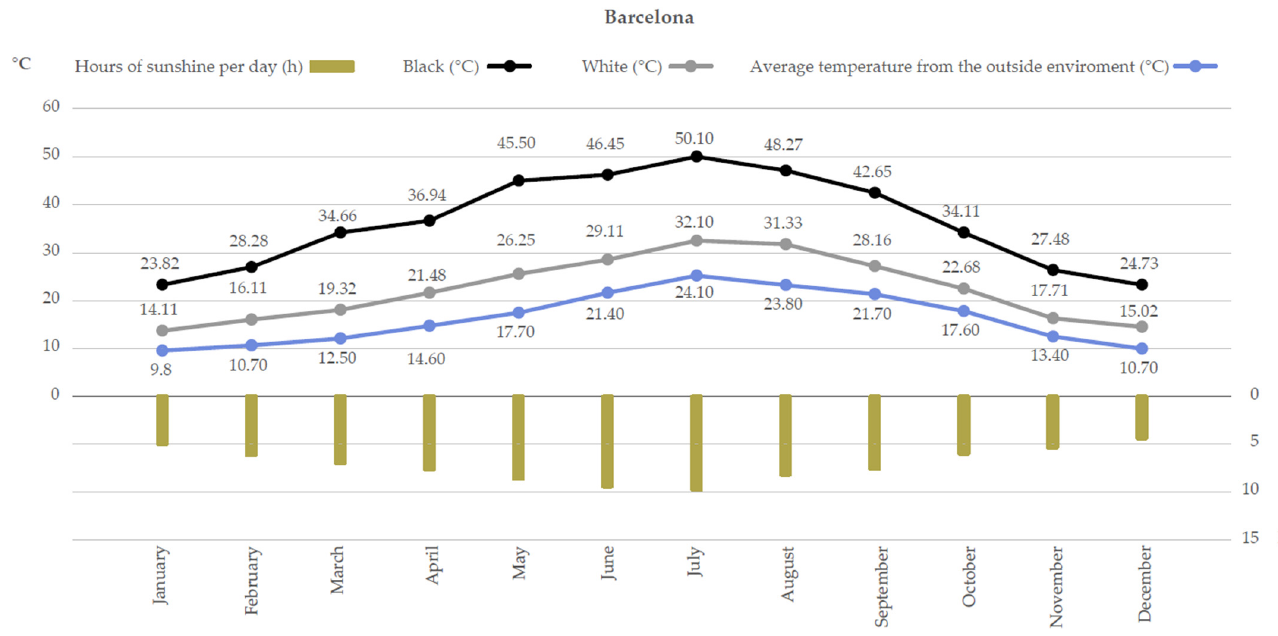
Figure 1. Surface temperatures of black and white roofs in Barcelona and the average monthly temperature [42].